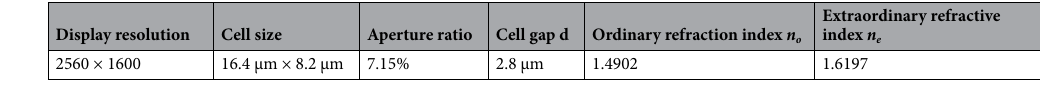
Table 1. The structural parameters of the fabricated IPS